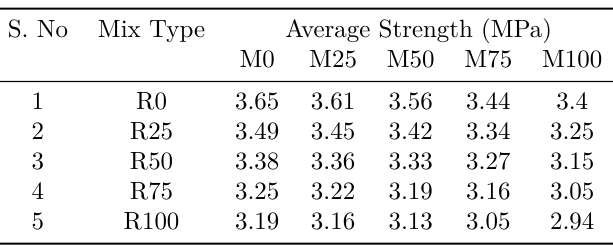
Table 3. Estimated split tensile strength of the various concrete mixtures.